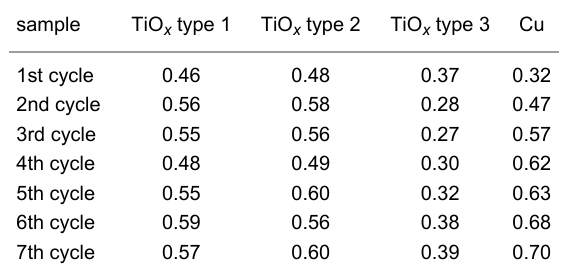
Table 1: Survival ratio of E.coli cells deposited on TiO x and Cu NPs after 120 min. In the case of TiO x the samples were exposed to UV